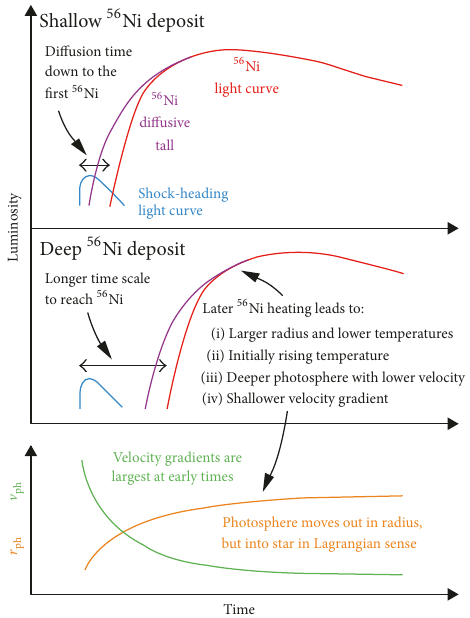
Figure 16: The effect of different degrees of nickel mixing in the ejecta of SNe Ibc on their observed LCs, from [290]. Top and middle panels: how the relative positions of the shock-heating contribution (blue curves), 56 Ni diffusive tail contribution (purple curves), and the 56 Ni contribution (red curves) to the observed LC can differ depending on the depth and amount of mixing of the 56 Ni. The total observed LC is the sum of these three components. When the 56 Ni is located deep in the ejecta (middle panel) and the shock-heating light curve (blue curve) is below the detection limits, there can be a sig- nificant dark phase between the time of explosion and the moment of first detection. Bottom: temporal evolution of the photospheric radius (orange curve) and velocity (green curve). Depending on the position of the 56 Ni LC, different photospheric radii, velocities, and velocity gradients will be present during the rising